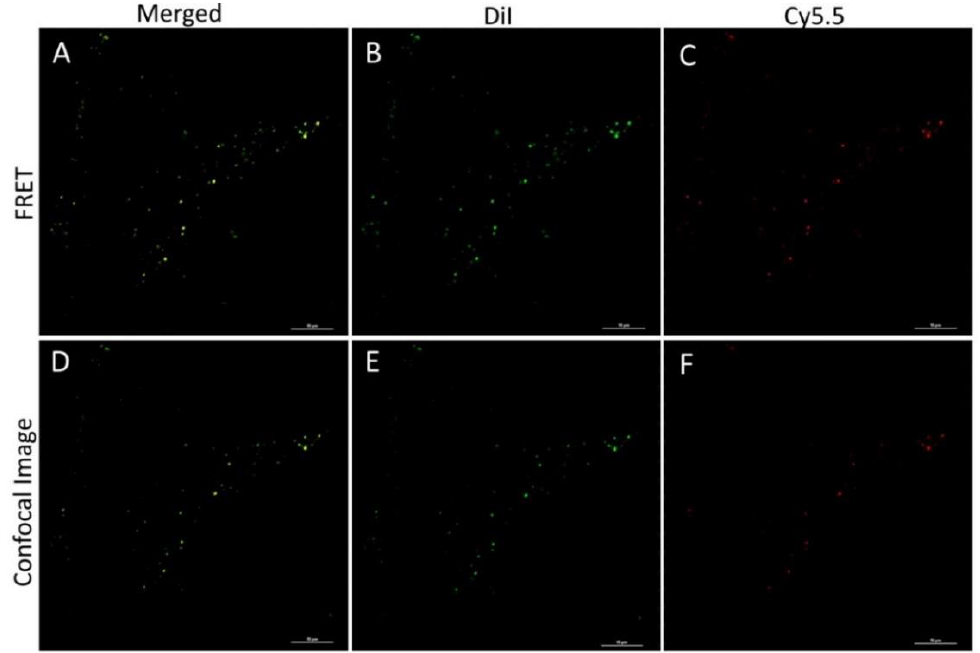
Figure 8. Imaging of 4T1 cells after 1 h of incubation with PLGA-Cy5.5/DiI NPs. Upper panels ( A – C ) represent the FRET signal at donor excitation wavelength (561 nm) -FRET phenomenon; lower panels represent DiI and Cy5.5 fluorescence separately (ex 561 and 647 nm); ( A , D )—merged images; ( B , E )—DiI fluorescence; ( C , F )—Cy5.5 fluorescence. Laser scanning confocal microscopy (Nikon A1 MP). Scale bar 10 μm.